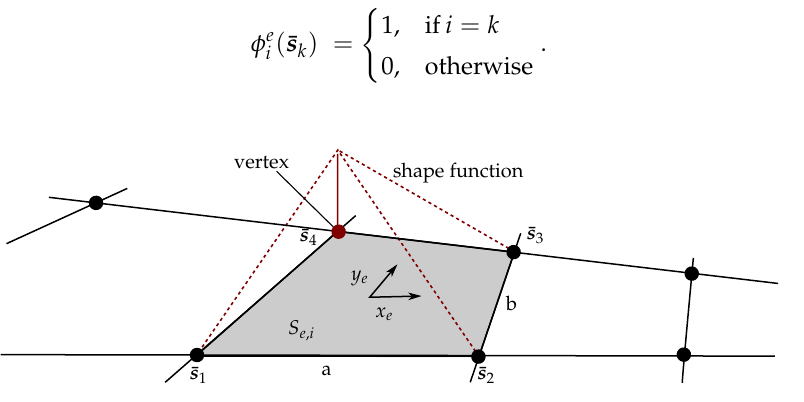
Figure 3. Shape function on a selected grid